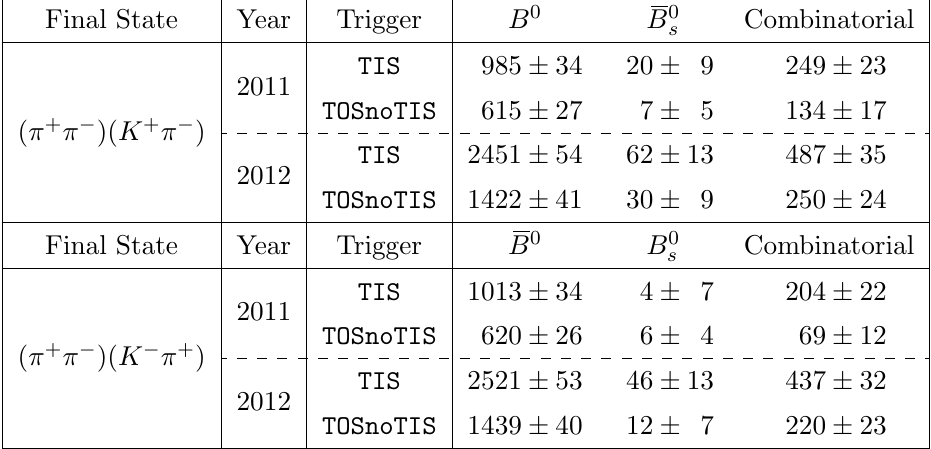
listed in table 2, are accounted for in the analysed region of the ( (cid:25) + (cid:25) (cid:0) ) and ( K + (cid:25) (cid:0) ) two-body invariant